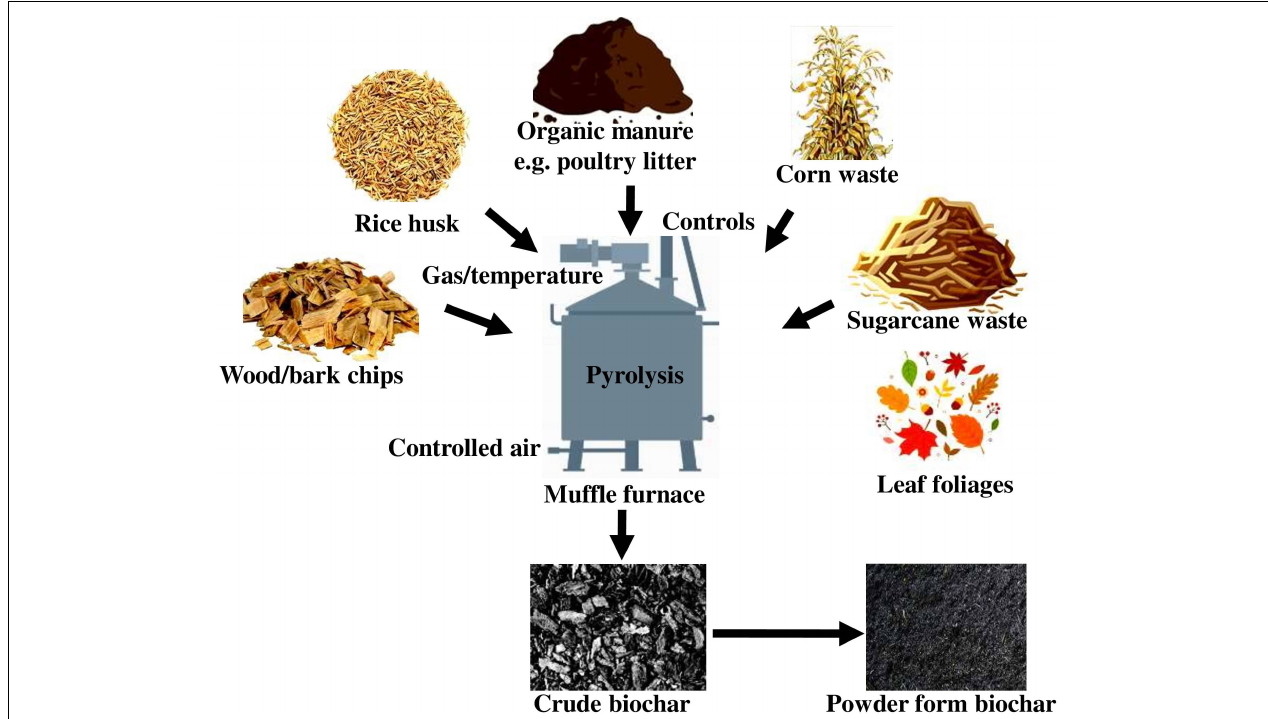
FIGURE 2 | Possible benefits of biochar amendment in bio- and